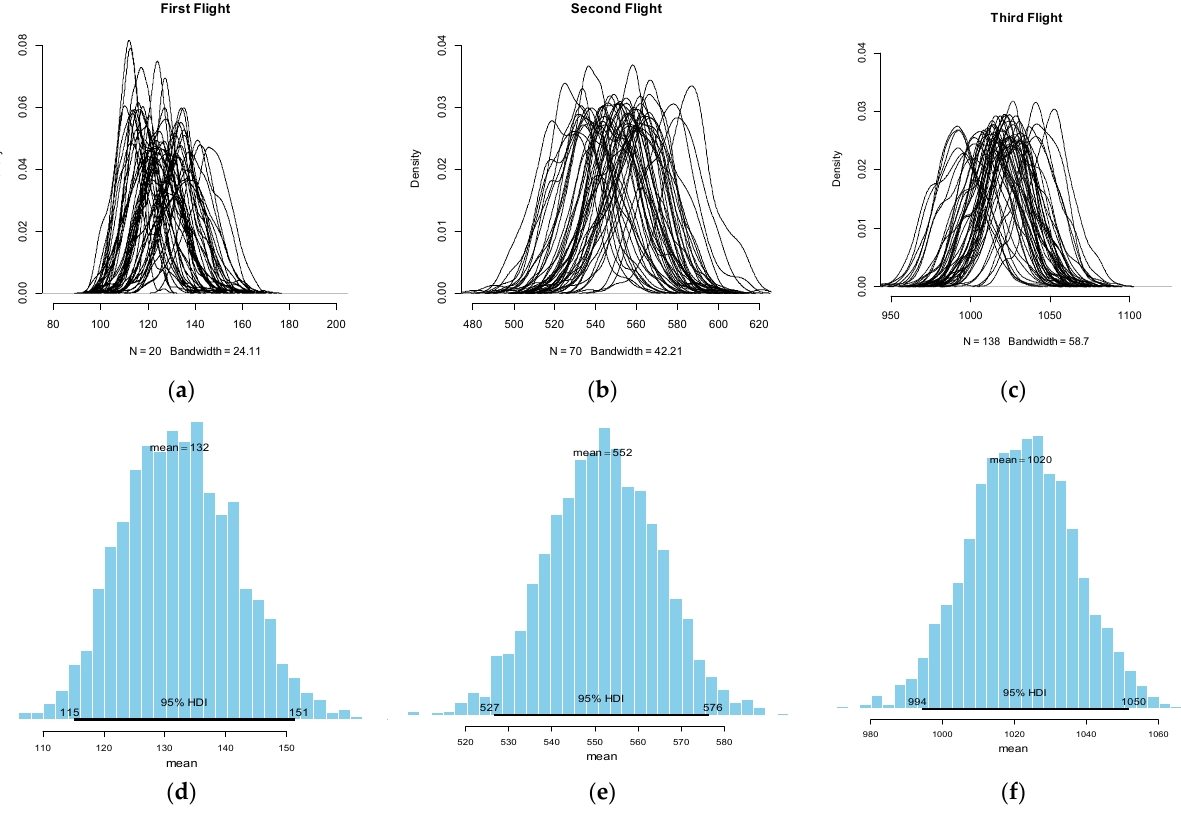
Figure 5. Some simulated bootstrapped densities (n = 50), for the first ( a ), second ( b ) and third ( c ) flight generations of H. armigera . Posterior frequency distributions according to the Bayesian bootstrap procedure (n = 10,000) for the first ( d ), second ( e ) and third flight ( f ) of H. armigera . Means represent the degree-days of the highest pest activity (i.e., peak in moth abundance) and HDI the related 95% high density intervals. Table 1. Degree ‐ day risk thresholds and related phenological metrics for H. armigera flight genera ‐ tion according to the non ‐ parametric Bayesian boostrap approach (n = 10,000 replications).